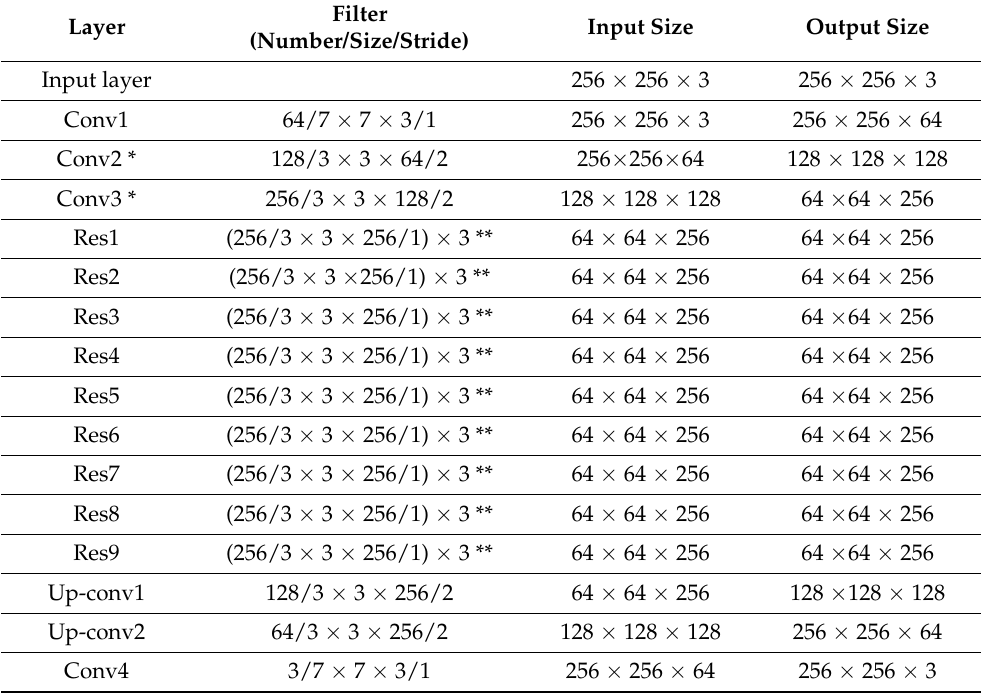
Figure 3. Summary of the CycleGAN structure. Table 2. Architecture of the generator used in CycleGAN.